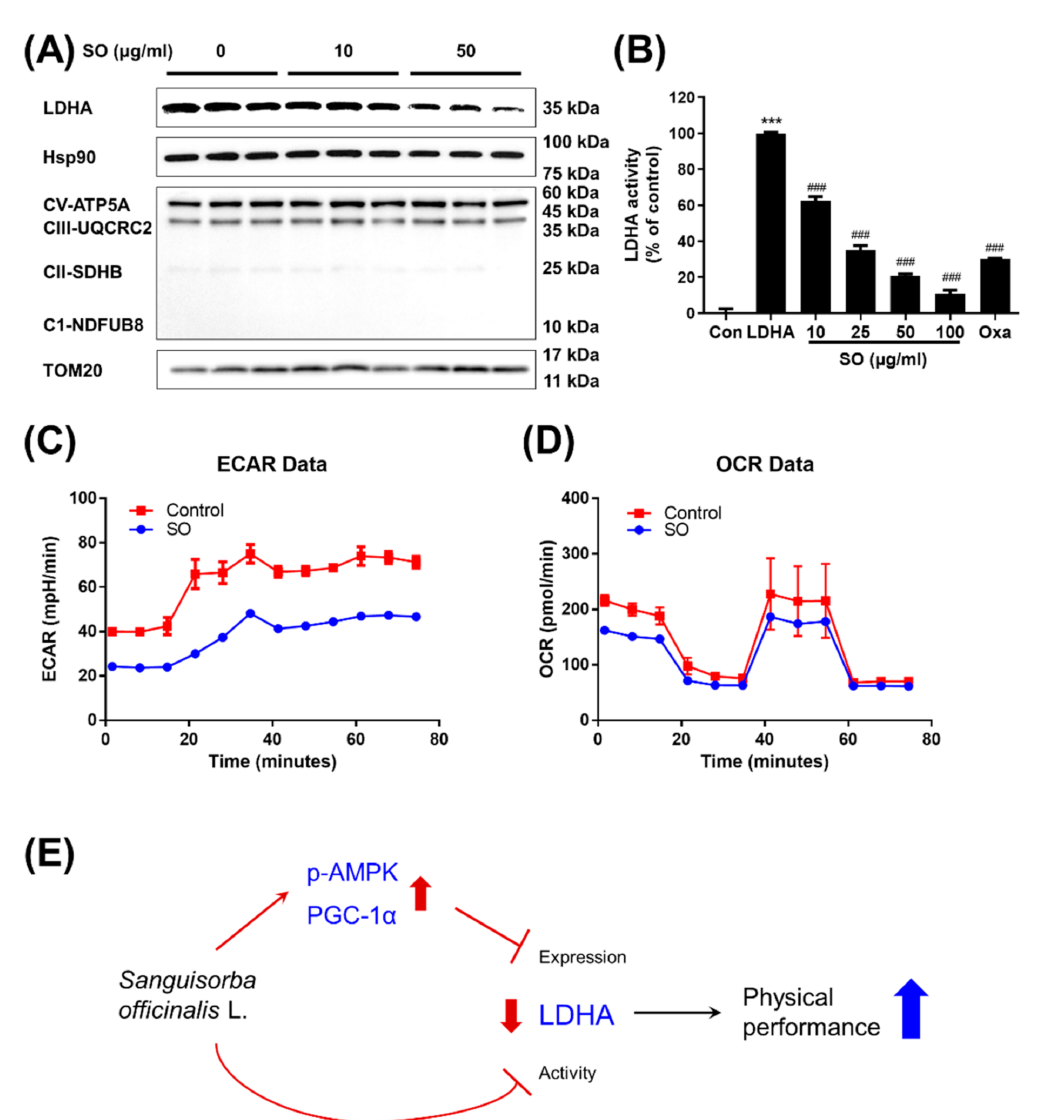
Figure 5. The mode-of-action of S. officinalis (SO) ( A ) The protein expression of LDHA, Hsp90, CV-ATP5A, CIII-UQCRC2, CII-SDHB, CI-NDUFB8, and TOM20 were measured by Western blot analysis. Hsp90 expression was used as a control. ( B ) The activity of LDHA was measured by in vitro LDHA assay using recombinant human LDHA in the presence of an indicated concentration of S. officinalis extract. The results were shown as mean ± SEM. *** p < 0.001 compared to the control. ### p < 0.001 compared to the negative control. Analysis of extracellular acidification rate (ECAR) ( C ) and oxygen consumption rate (OCR) ( D ) was performed using a Seahorse XF analyzer to assess glycolysis and mitochondrial respiration, respectively. ( E ) Schematic representation of inhibition of S. officinalis extract on the LDHA expression and activity and subsequently enhancing the physical performance was